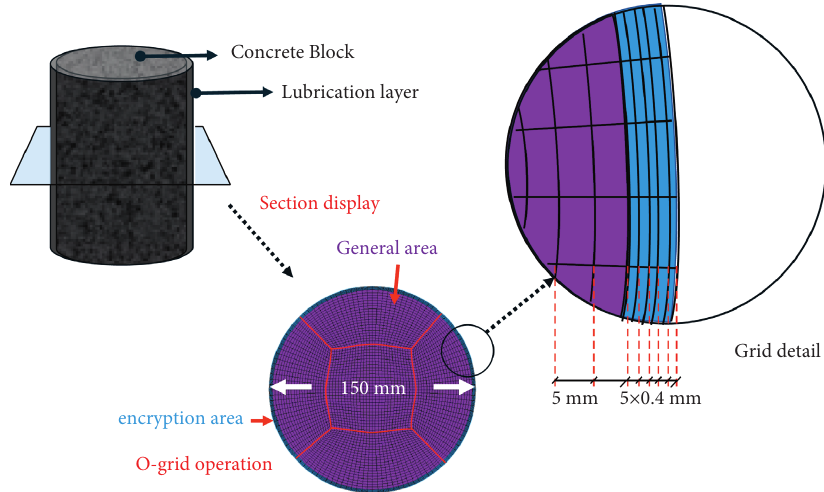
Figure 3: The topological mesh considering the lubrication